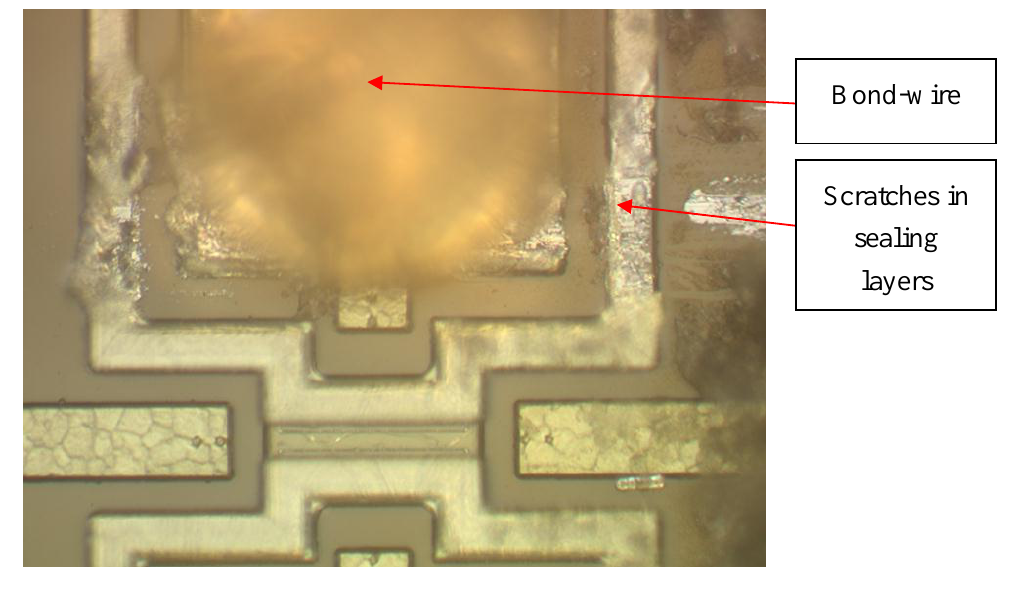
Figure 13. Bond needle damage to a sealing structure